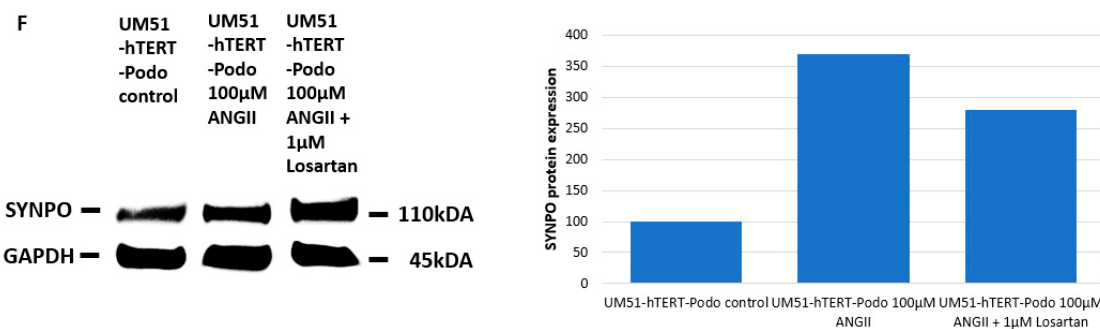
Figure 5. Effects of angiotensin II on the differentiated UM51-Pre-Podo-hTERT cultured in adv. RPMI. UM51-Pre-Podo-hTERT cultured in adv. RPMI supplemented with 30 µ M retinoic acid was treated with 100 µ M ANGII for 24 h or a combination of 48 h 1 µ M Losartan and 24 h 100 µ M ANGII. The top panel shows the control morphology. The next two panels show morphology changes after 24 h of 100 µM ANGII treatment, and the last two panels show the morphology for the combination of Losartan and ANGII. The cytoskeleton was visualized by immunofluorescence-based detection of α –ACTININ in red ( A ) (scale bars: 50 µm). Expression of ANGII receptors AGTR1 ( B ), AGTR2 ( C ) and expression of podocyte marker SYNPO ( D ), and NPHS1 ( E ) were determined by quantitative real-time PCR normalized with the ribosomal encoding gene-RPL0. Expression of the podocyte marker synaptopodin was determined by Western blotting ( F ).